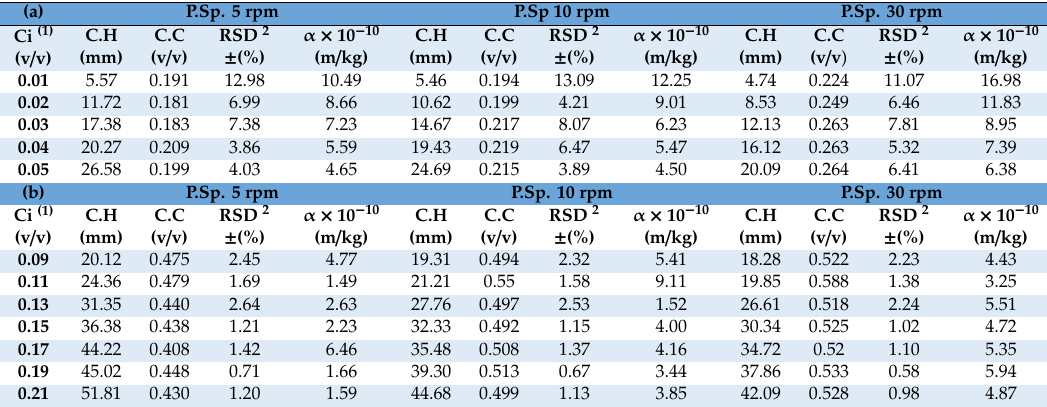
( α ) Cake resistance from filtration equation, Equation (1). 2 Relative standard deviation (RSD) based on cake height measurement variability from five points for each test, leading to uncertainty value for cake concentration.